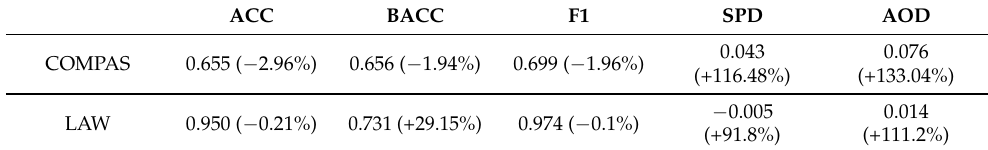
Table 7. LRC results after reweighing the training set. Performance was evaluated using stratified 10-fold CV. For SPD and AOD, values closer to zero indicate more fairness. The percentages in brackets display the differences compared to the baseline results as presented by Table 4. ACC BACC